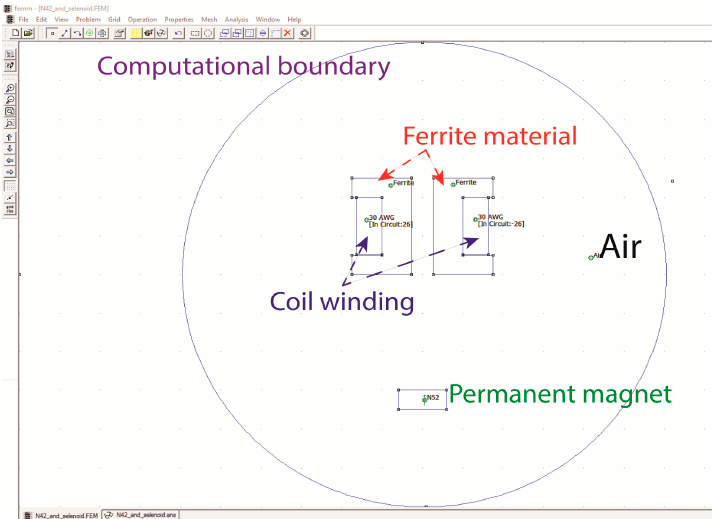
Figure 3. Plotted EMAwS in FEMM software.